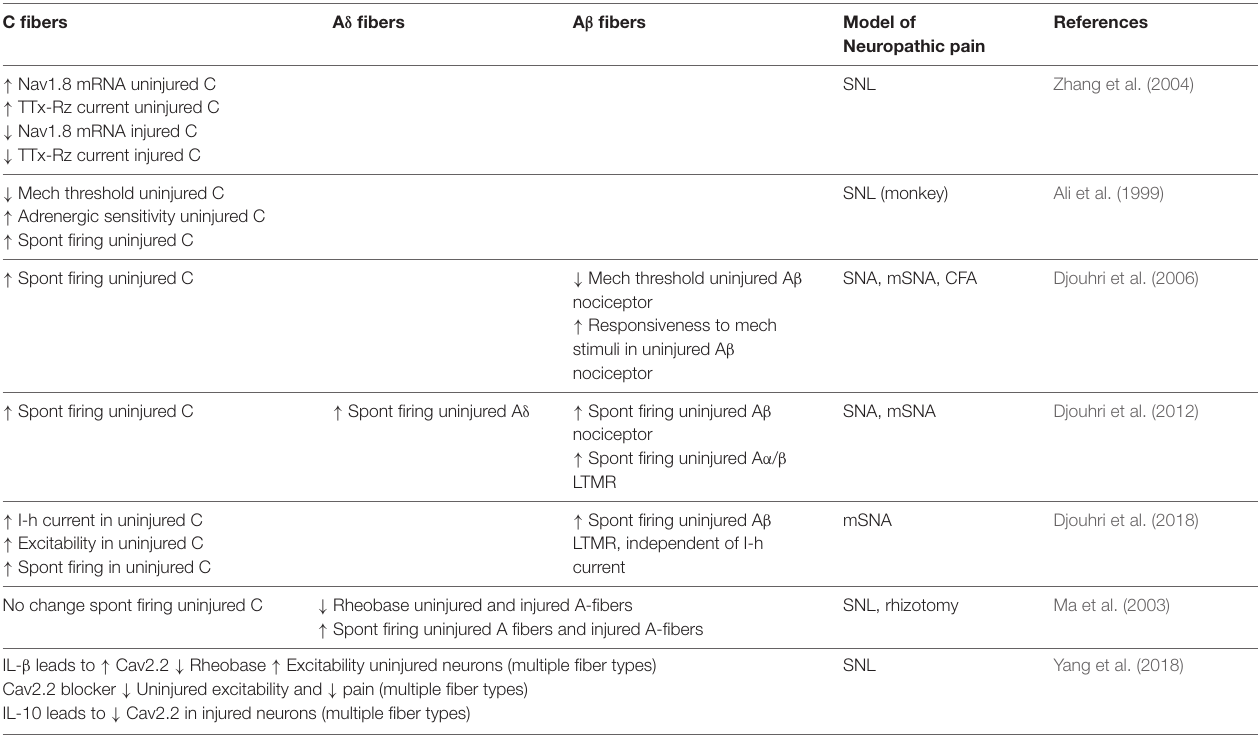
TABLE 1 | Neurophysiologic changes in uninjured sensory neurons after nerve